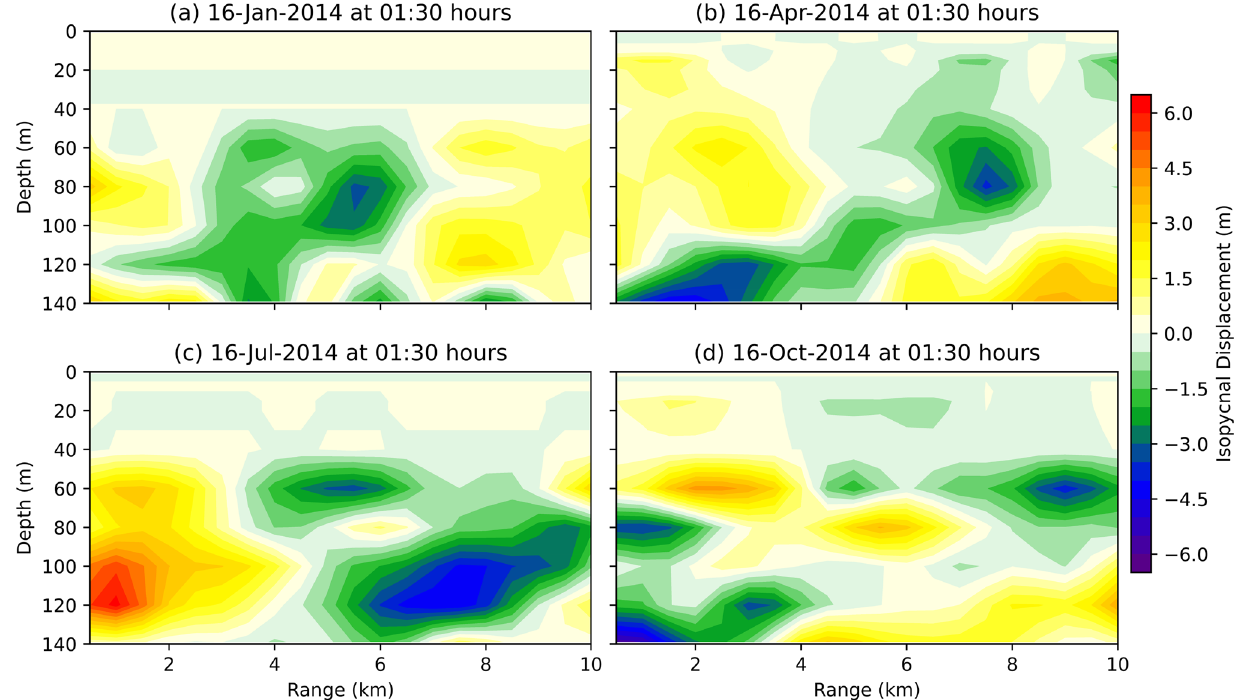
Figure 4. Vertical distribution of isopycnal displacements within a range of 10 km from RAMA buoy simulated by coupled model at 01:30 hours on ( a ) 16 January 2014, ( b ) 16 April 2014, ( c ) 16 July 2014, and ( d ) 16 October